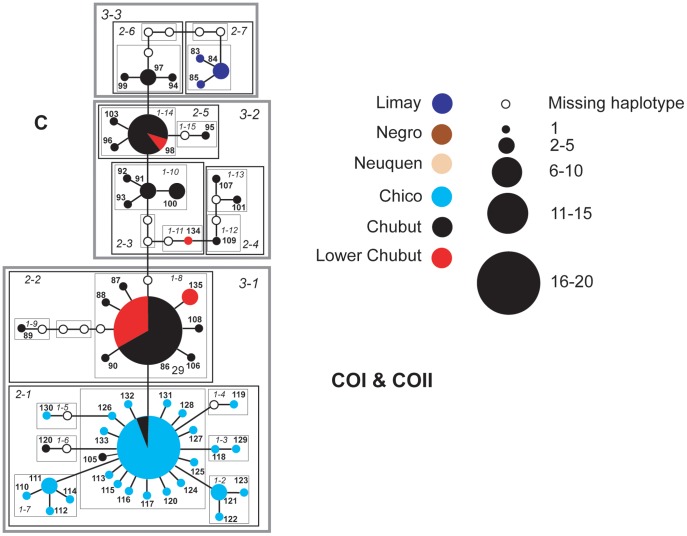
Haplotype network with nested clade design for mtDNA (COI & COII) sequence data comprised mostly of individuals from the Chico and Chubut Rivers.Haplotype circle size is proportional to its frequency. Each haplotypes is numbered. Haplotypes that exceed twenty individuals are labeled with the total number of individuals of that haplotype. Arrow indicates the root haplotype. Black empty circles represent extinct (or unsampled) haplotypes. Color codes indicate the six major rivers.